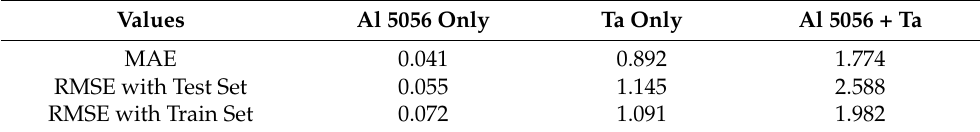
Table 4. MAE and RMSE values for each dataset.